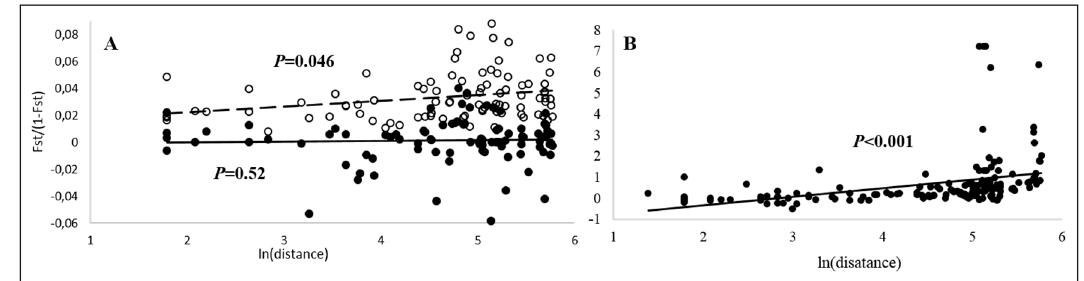
Figure 4. Isolation-by-distance in nuclear ( A ) and mitochondrial ( B ) markers in P. biglumis . In panel A, open circles and dashed line are for DNA microsatellites and closed circles and solid line for AFLP markers. In nuclear markers, only populations with n > 2 were included. Matrix correlation was significant in DNA microsatellite and mitochondrial markers, but not in AFLP markers.